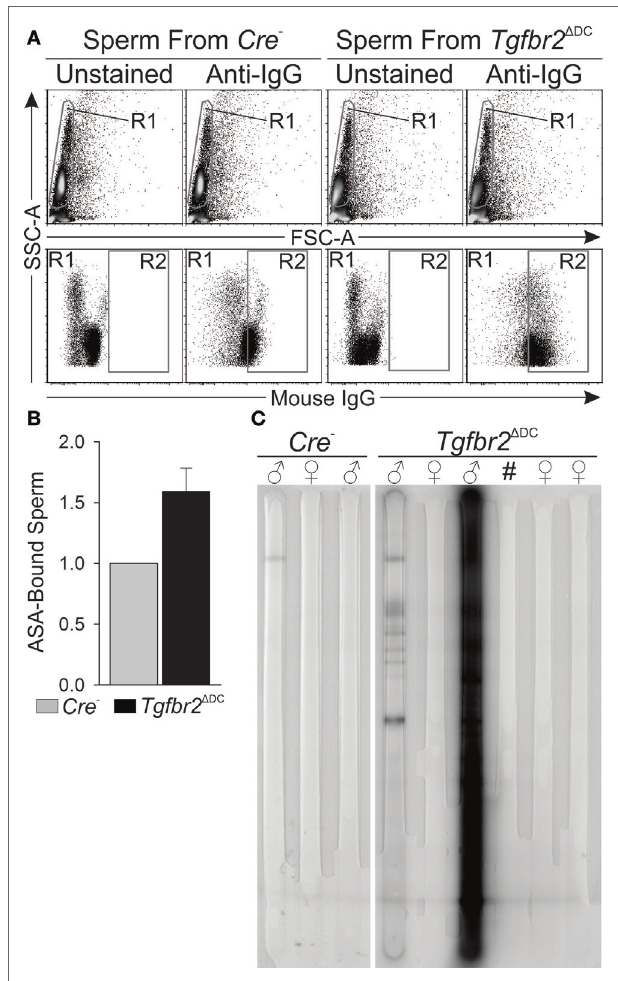
FigUre 5 | Adult Tgfbr2 Δ DC males exhibit sperm-specific immune response. (a) Typical flow cytometry outcomes that detected immunoglobulins (IgGs) bound to sperm [antisperm antibodies (ASAs)]. Sperm (gated in R1) were determined to be “positive” or “ASA-bound” if their fluorescence signal was intense enough to place a particular sperm cell within R2. (B) Summary of IgG-bound sperm quantifications. In each paired observation, the quantity (% of all sperm) of IgG-bound sperm from the Cre − male was taken as baseline (value = 1) and the mean fold-change of IgG-bound sperm from Tgfbr2 Δ DC littermates is shown. N = 4, and 100,000 events recorded per sample. (c) Immunoblot-based assay that detected free ASAs (IgGs) in sera. Signals were generated where ASAs in sera bound to sperm antigens immobilized on the membrane. Signals are multiple and intense for the second Tgfbr2 Δ DC male shown. All samples tested by this method are shown. All mice tested were ages 8–10